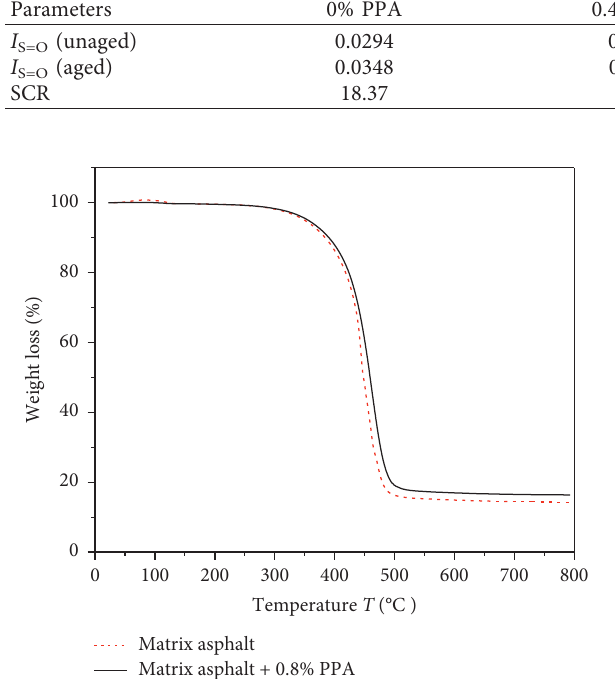
Figure 11: TG results of matrix asphalt and PPA-modified